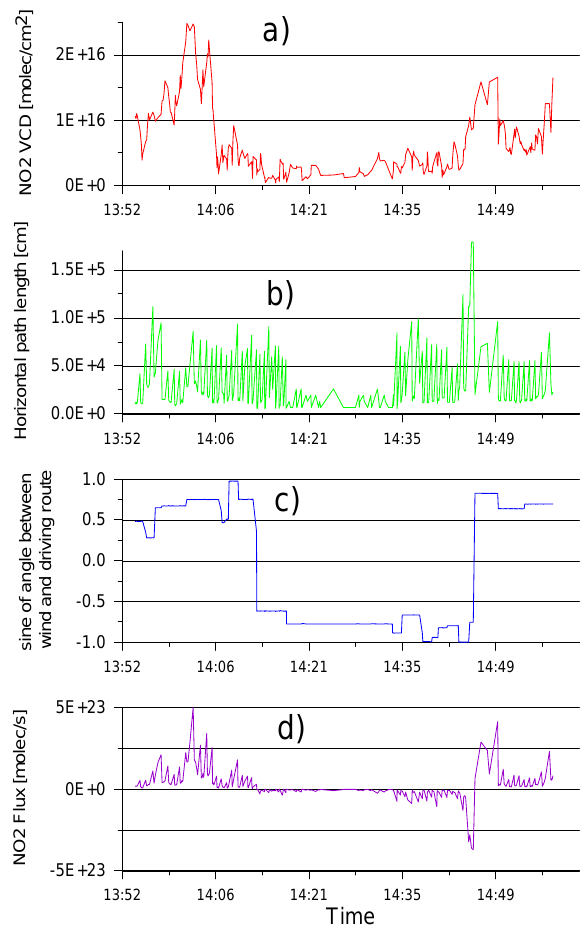
Fig. 6 Different components used for the net flux estimation shown for loop #4 on Fig. 6. Different components used for the net flux estimation shown 24.08.2006. In a) the observed NO 2 VCD are presented. Fig. 6b shows the driving distance for loop #4 on 24 August 2006. In (a) the observed NO 2 VCD are between two consecutive observat ions’ and c) the sine of the angle between the driving route presented. (b) shows the driving distance between two consecu- tive observations’ and (c) the sine of the angle between the driving and the wind direction. In d) the resulting NO 2 flux is shown: negative fluxes indicate import route and the wind direction. In d) the resulting NO 2 flux is shown: and positive fluxes export from the encircled area. negative fluxes indicate import and positive fluxes export from the encircled